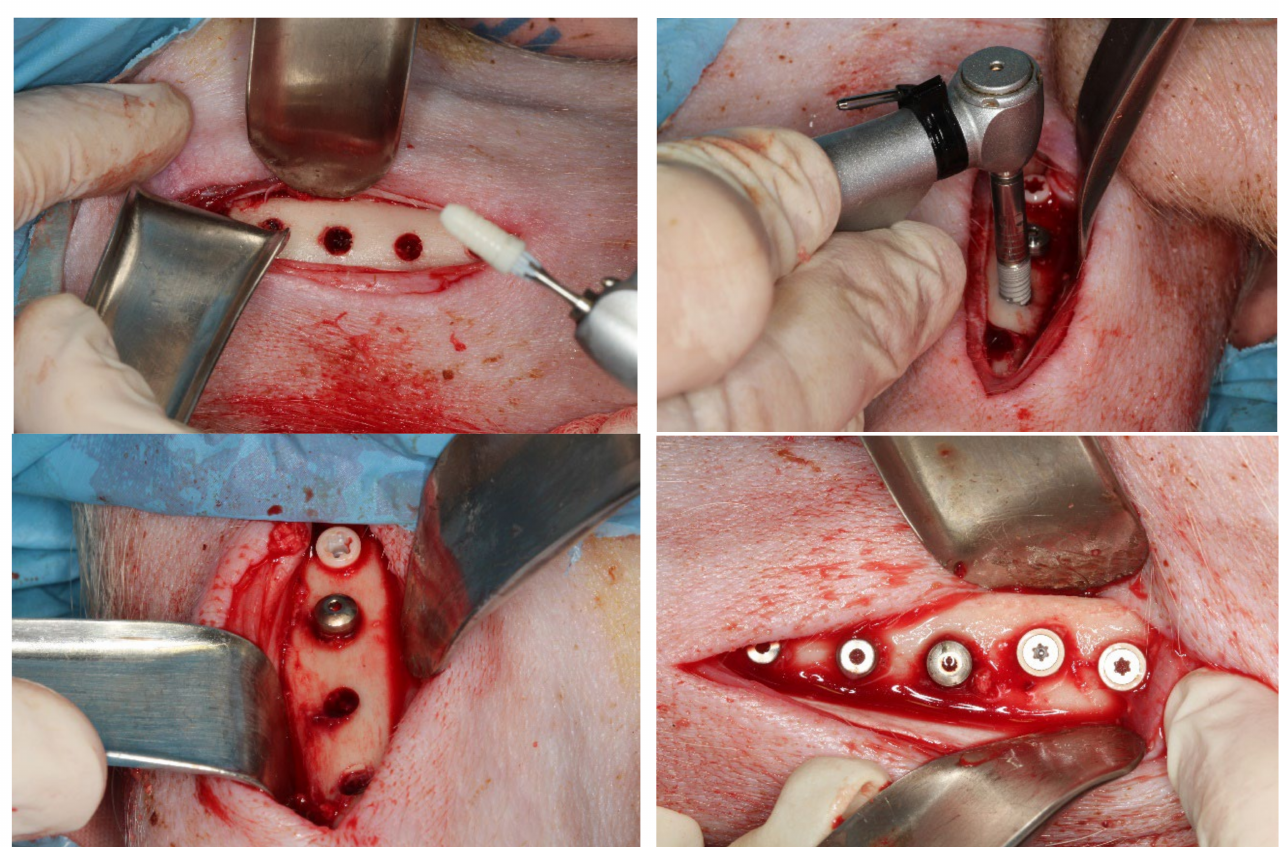
Figure 2. Images of the surgical procedure for implant